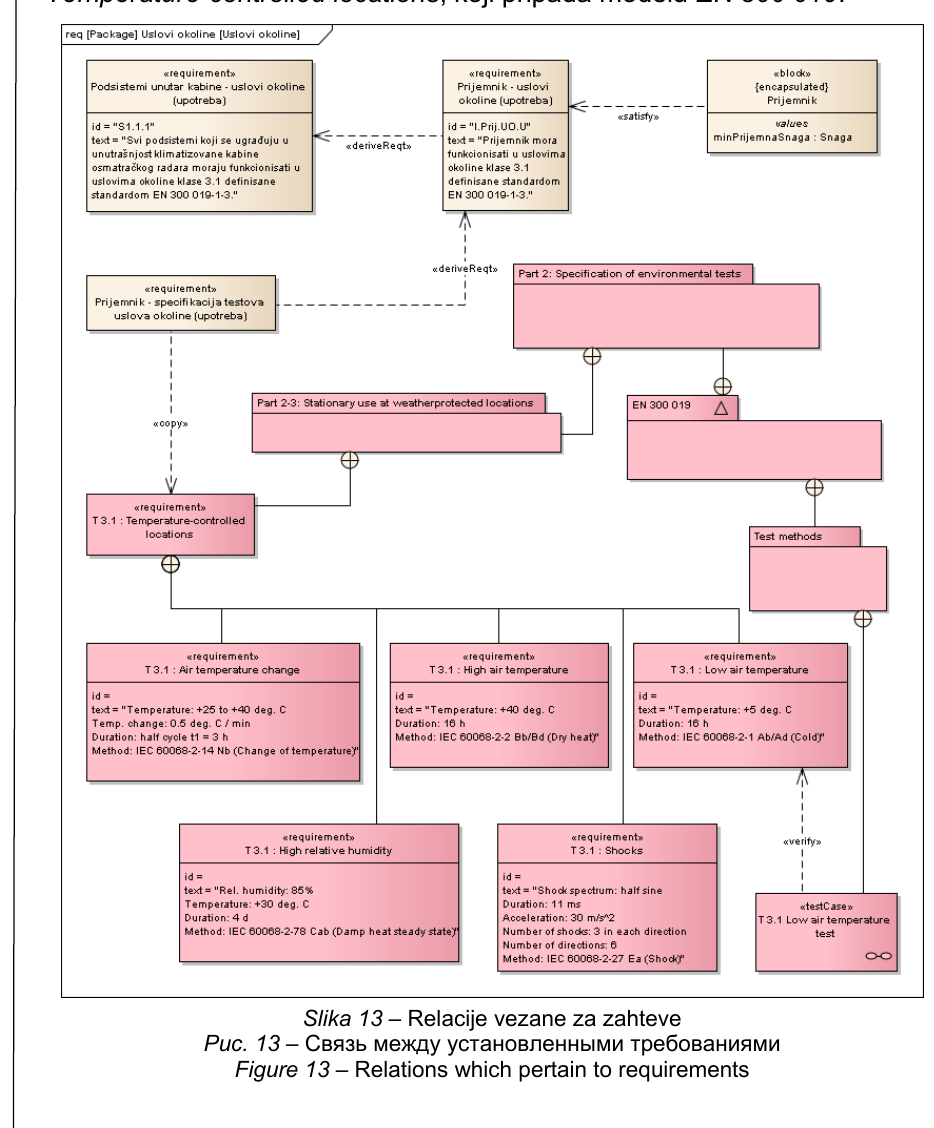
Рис . 13 – Связь между установленными требованиями Figure 13 – Relations which pertain to